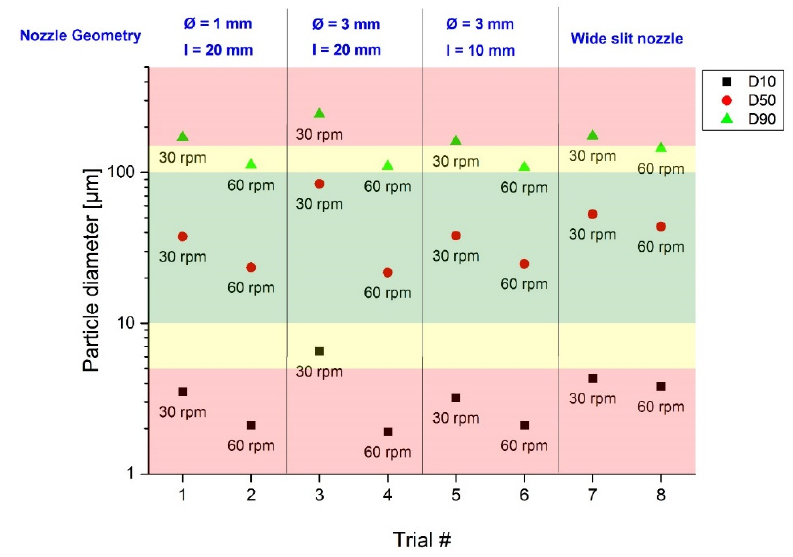
Figure 3. Particle size (D 10 , D 50 , D 90 ) in dependence of nozzle selection and extruder rotational speed. Colored regions indicate optimal size region (green), suboptimal size regions (yellow), and undesired size regions (red).